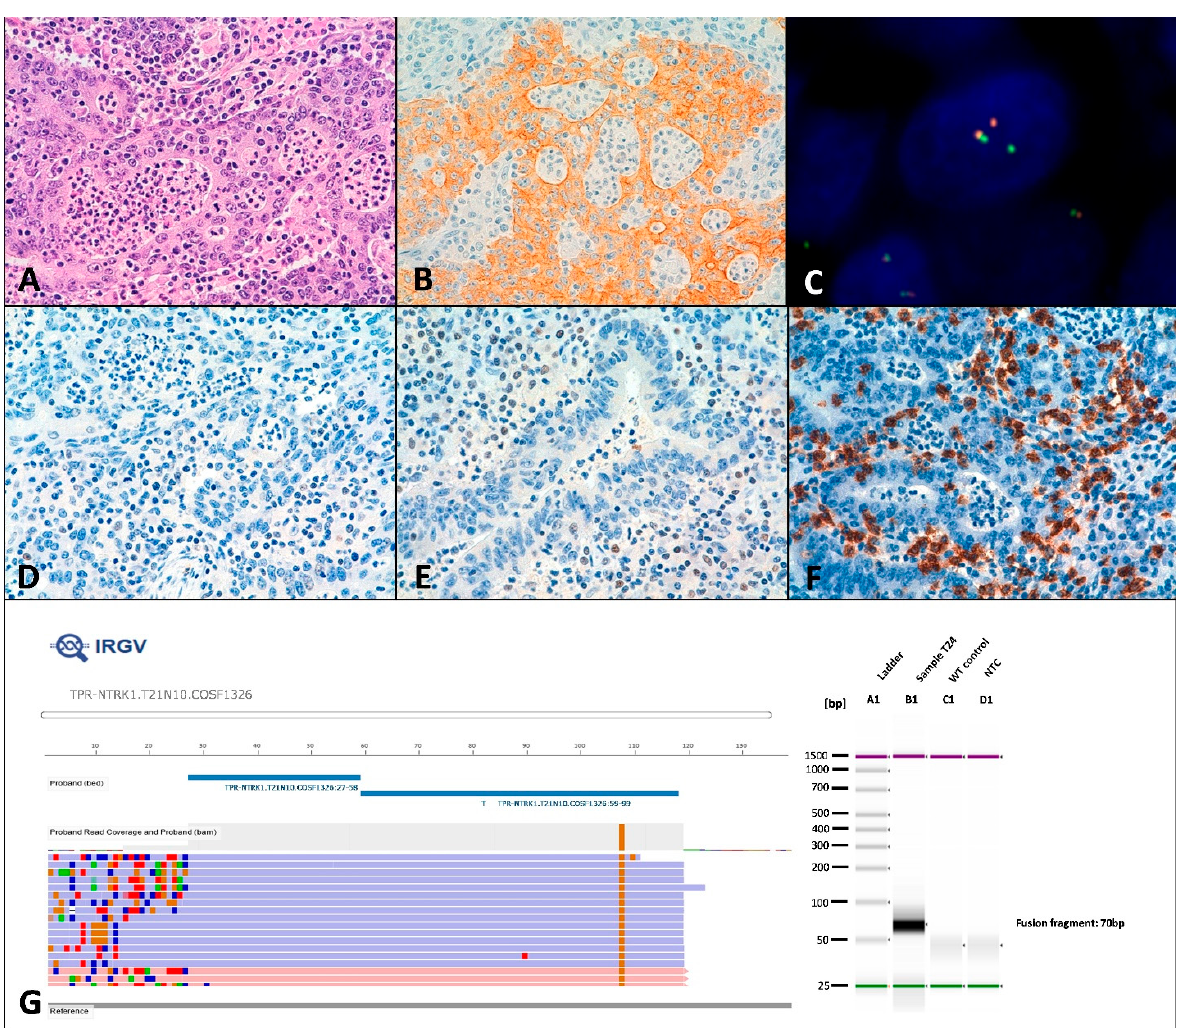
Figure 2. NTRK fusion in tumor T7. ( A ) Hematoxylin–eosin staining showing a solid carcinoma with a lymphoid infiltrate. ( B ) PAN-NTRK immunohistochemistry had a diffuse positive membrane patter. ( C ) ZytoLight SPEC NTRK1 FISH showing separate signals. ( D ) MLH1 and ( E ) PMS2 loss of expression. ( F ) CD8 highlights the abundant lymphoid infiltrate. ( G ) On the left, Ion Reporter Genomic Viewer (IRGV) image, corresponding to the TPR(21)-NTRK1(10) fusion. On the right, fusion validation by RT-PCR.